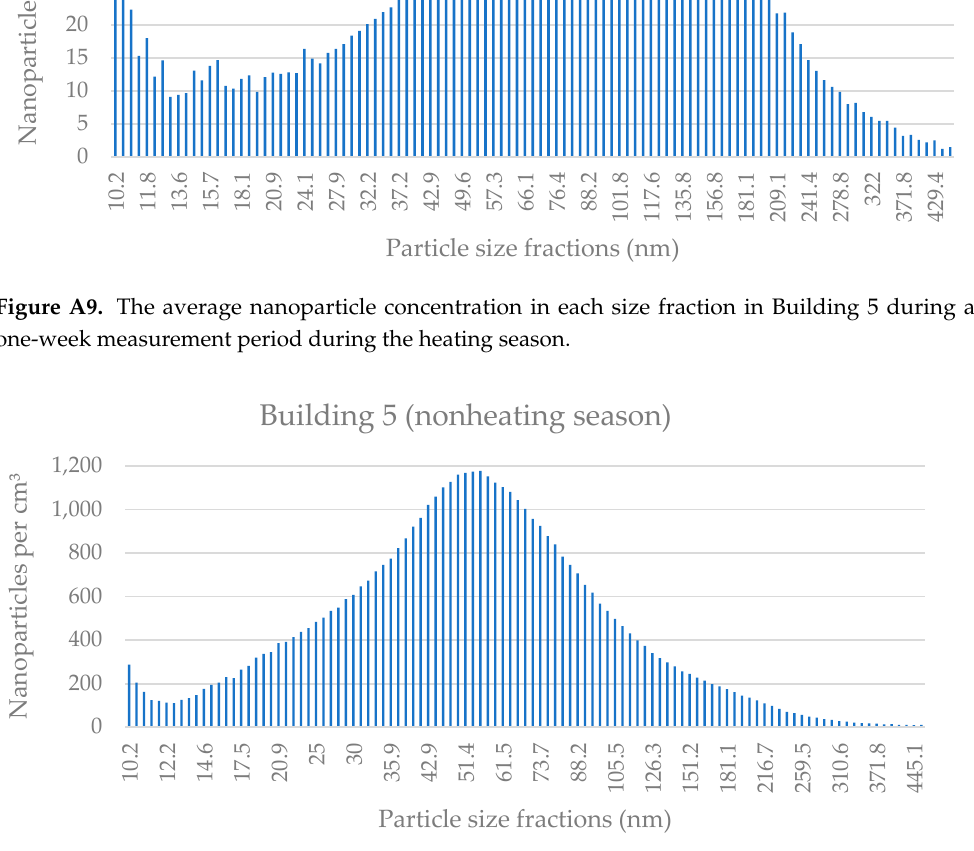
Figure A10. The average nanoparticle concentration in each size fraction in Building 5 during a one-week measurement period during the nonheating season.